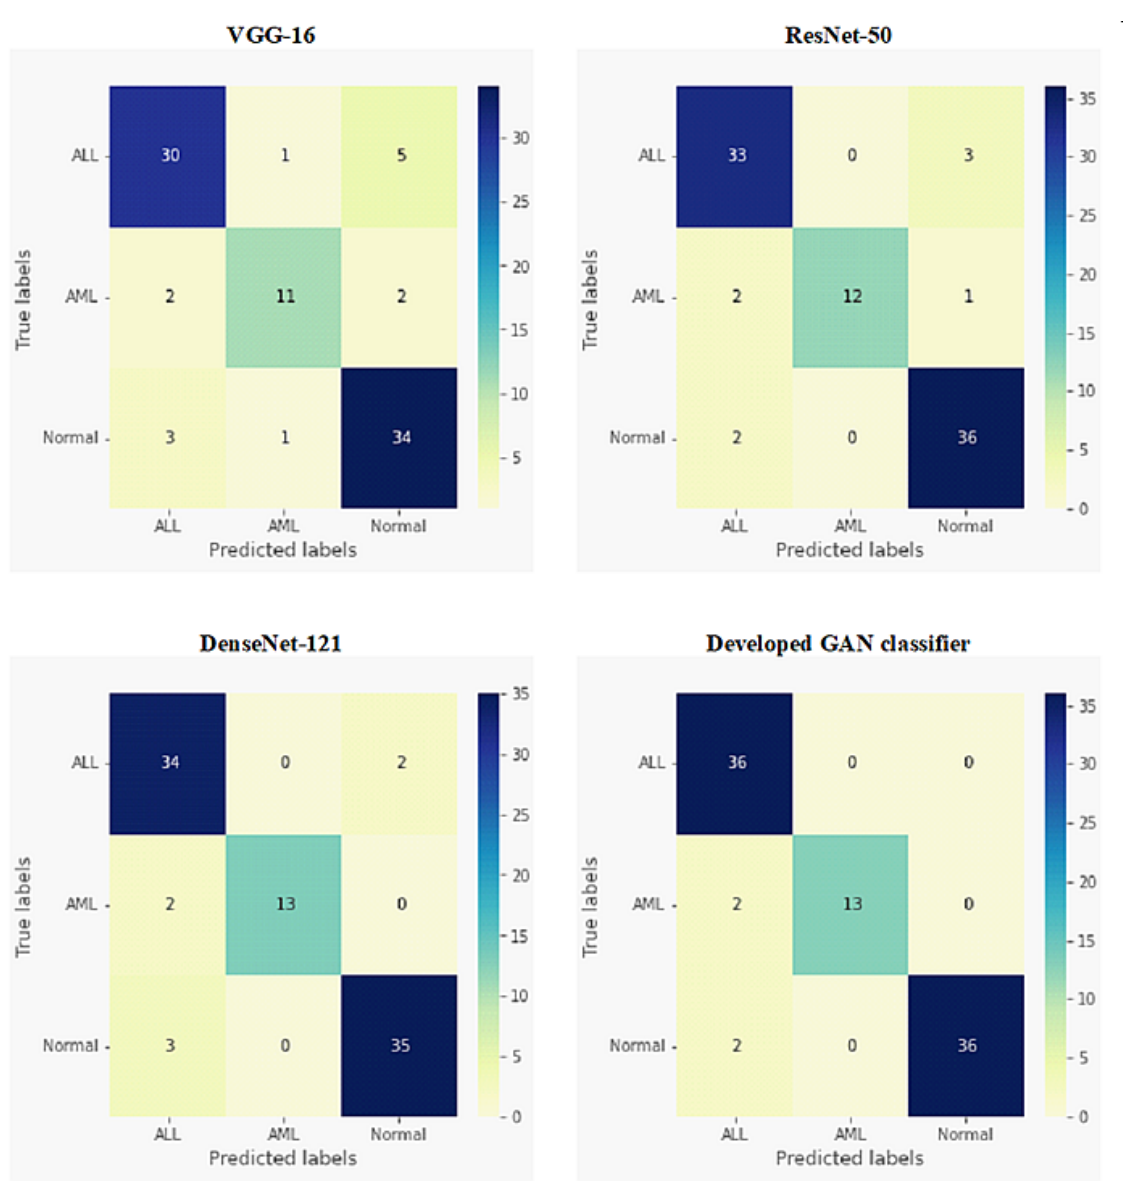
Figure 7. Confusion matrices for multi-class classification of ALL, AML, and normal blood cells for all tested deep network